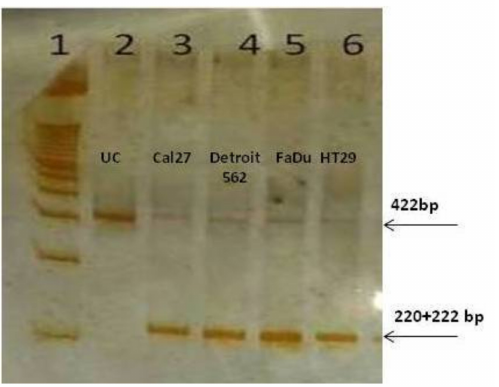
Figure 4. PKM2 transcripts prevail in the untreated cells. 1. DNA Ladder; 2. uncut fragment Cal27; 3–6. restricted fragments obtained with Kas1 in all four cell lines analyzed.